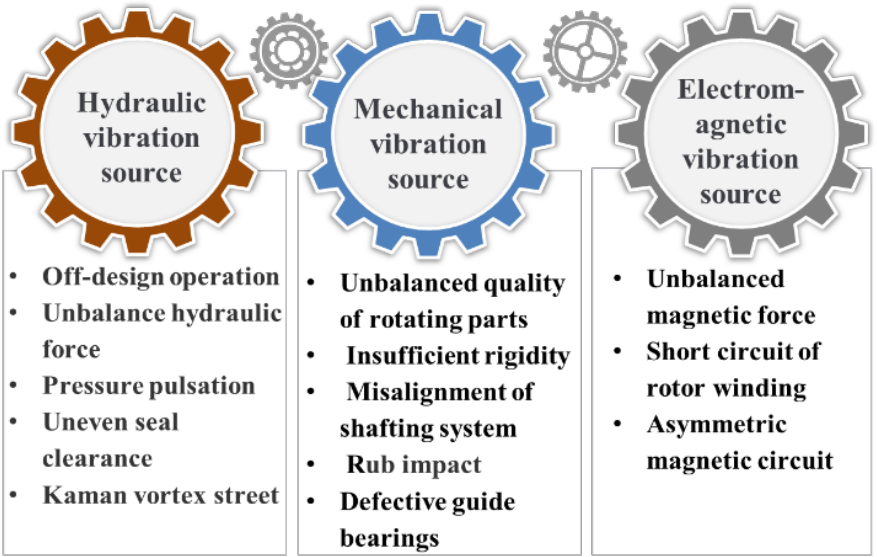
Figure 8. Main influencing factors of unit vibration.